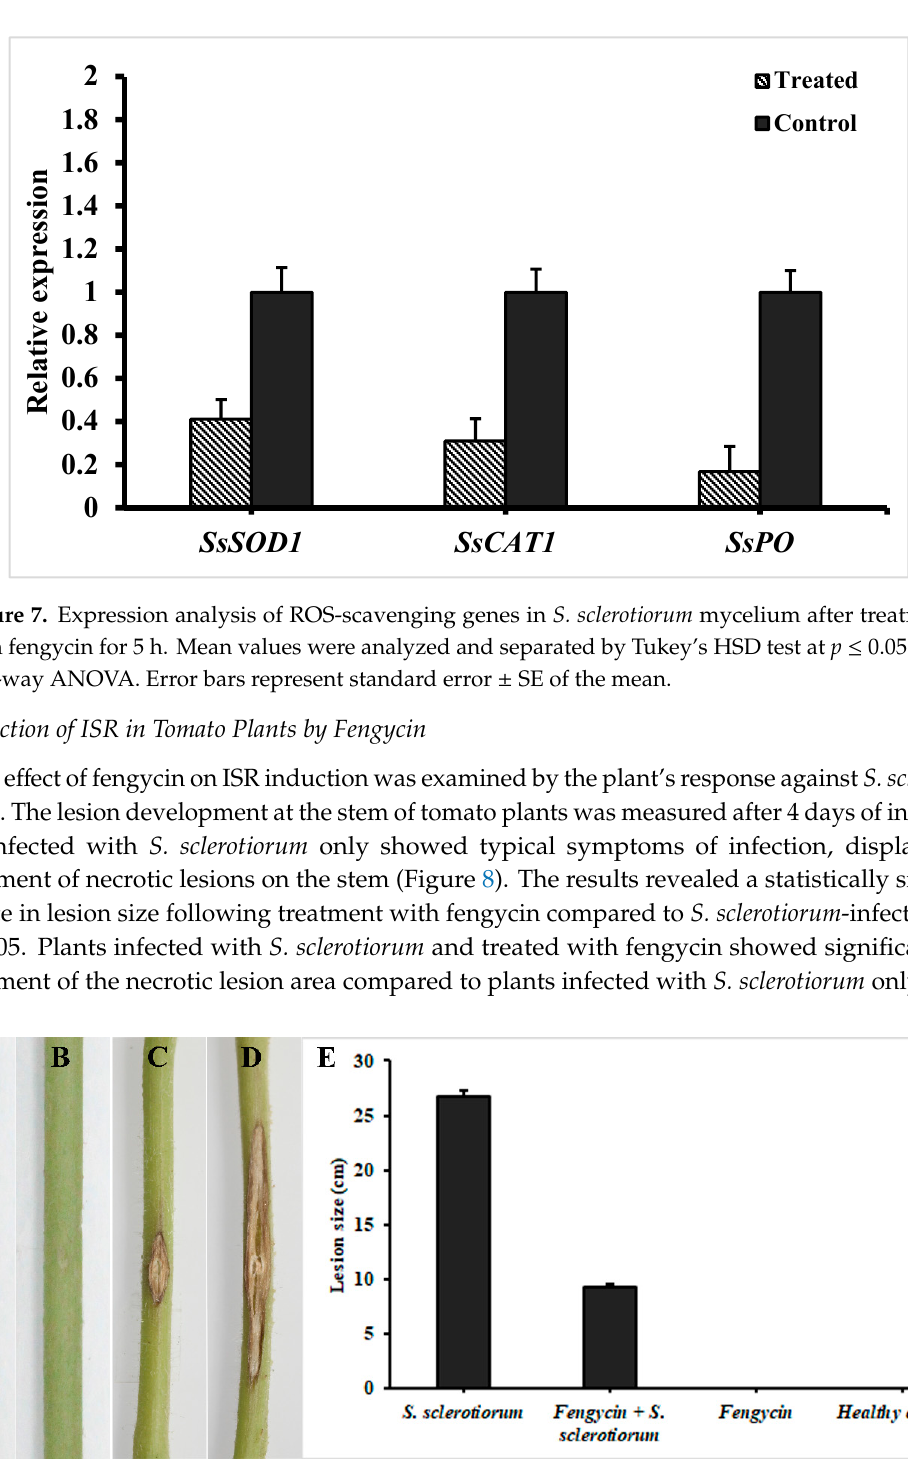
Figure 8. Fengycin-induced systemic resistance (ISR) in tomato plants against S. sclerotiorum . ( A ) healthy control, ( B ) fengycin only, ( C ) fengycin + S. sclerotiorum , ( D ) S. sclerotiorum only (infected control), and ( E ) lesion size (cm). Mean values were analyzed and separated by Tukey’s HSD test at p ≤ 0.05 after one-way ANOVA. Error bars represent standard error ± SE of the mean.